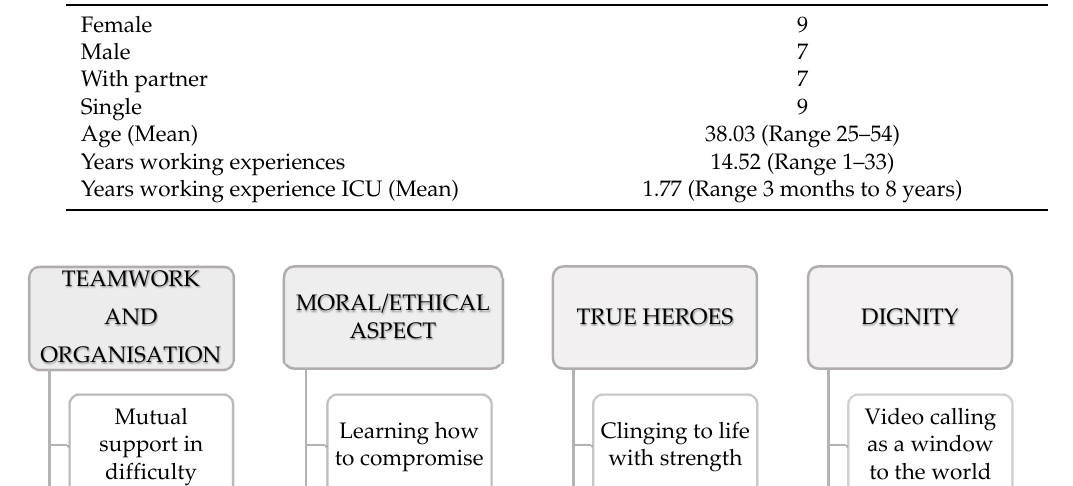
Table 2. Participant characteristics (N = 16).